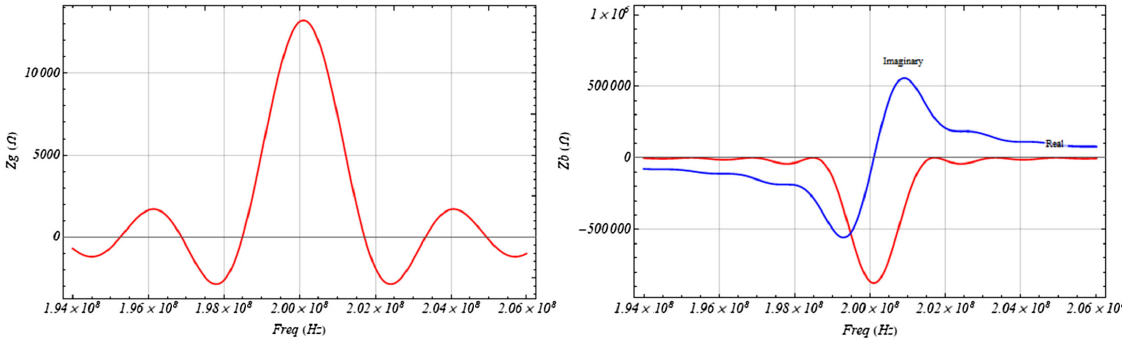
f Þ after compensation of the τ = 2 delay. Right: real (red) and imaginary parts of Z g ð